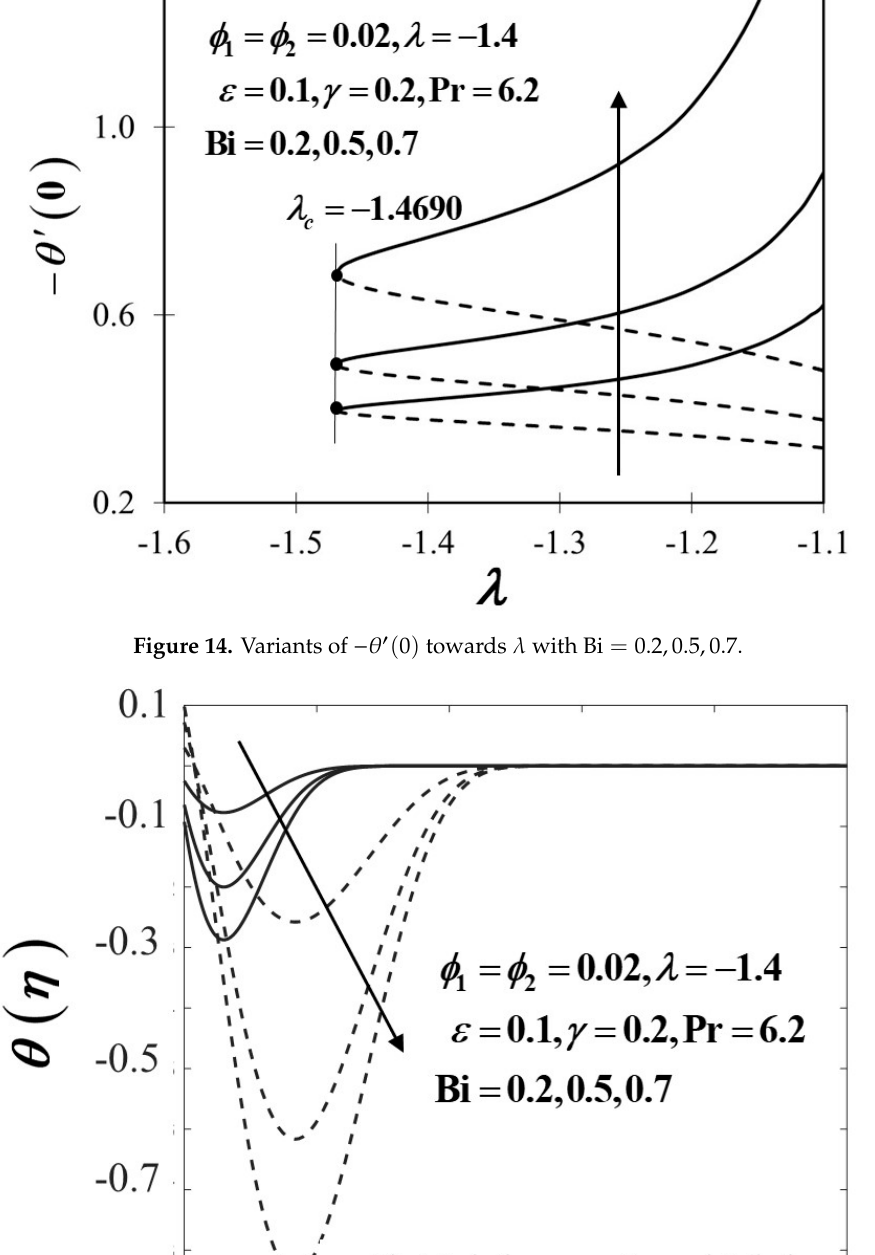
Figure 13. Temperature profiles of